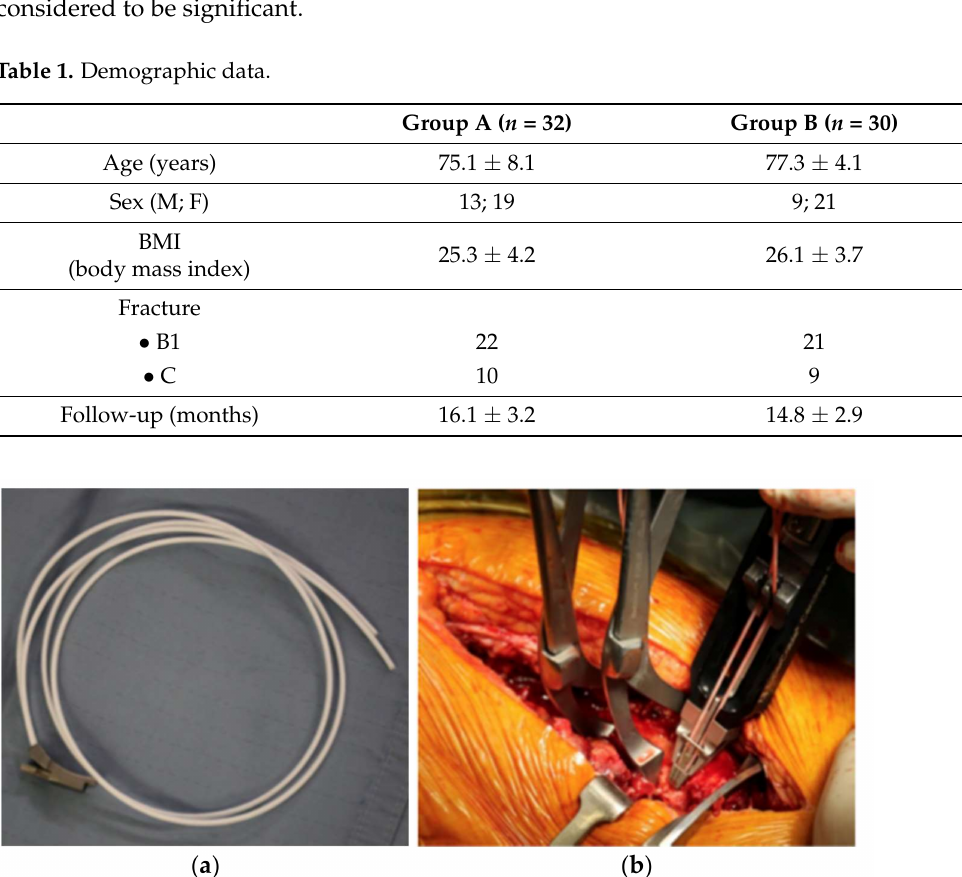
Figure 1. ( a ) UHMWPe cerclage cables (SuperCable TM ; Kinamed Inc., Camarillo, CA, USA); ( b ) ten- sioning instrument allows for tightening and locking of